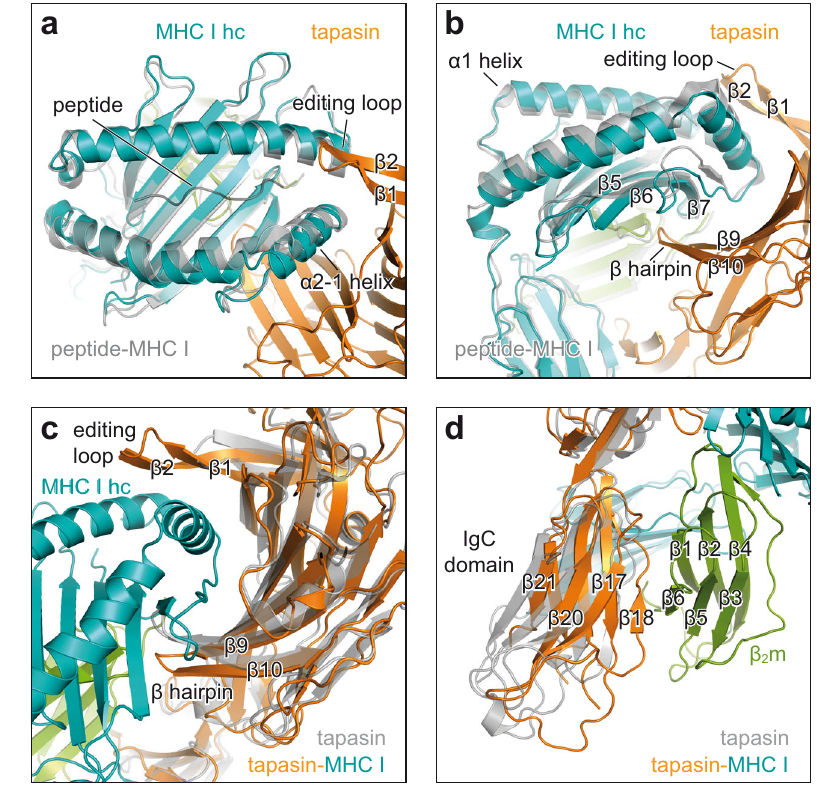
Fig. 2 | Conformational changes upon client-chaperone engagement. a Top view of superpositing peptide-receptive MHC I in the chaperone complex (MHC I hc, teal; tapasin, orange) with peptide-bound H2-D b (gray, PDB ID 2F74) in cartoon representation. hc heavy chain; β 1, β 2, β strands of editing loop of tapasin. b Side view of the superposition shown in a β 5, β 6, β 7, β strands of MHC I hc; β 9, β 10, β